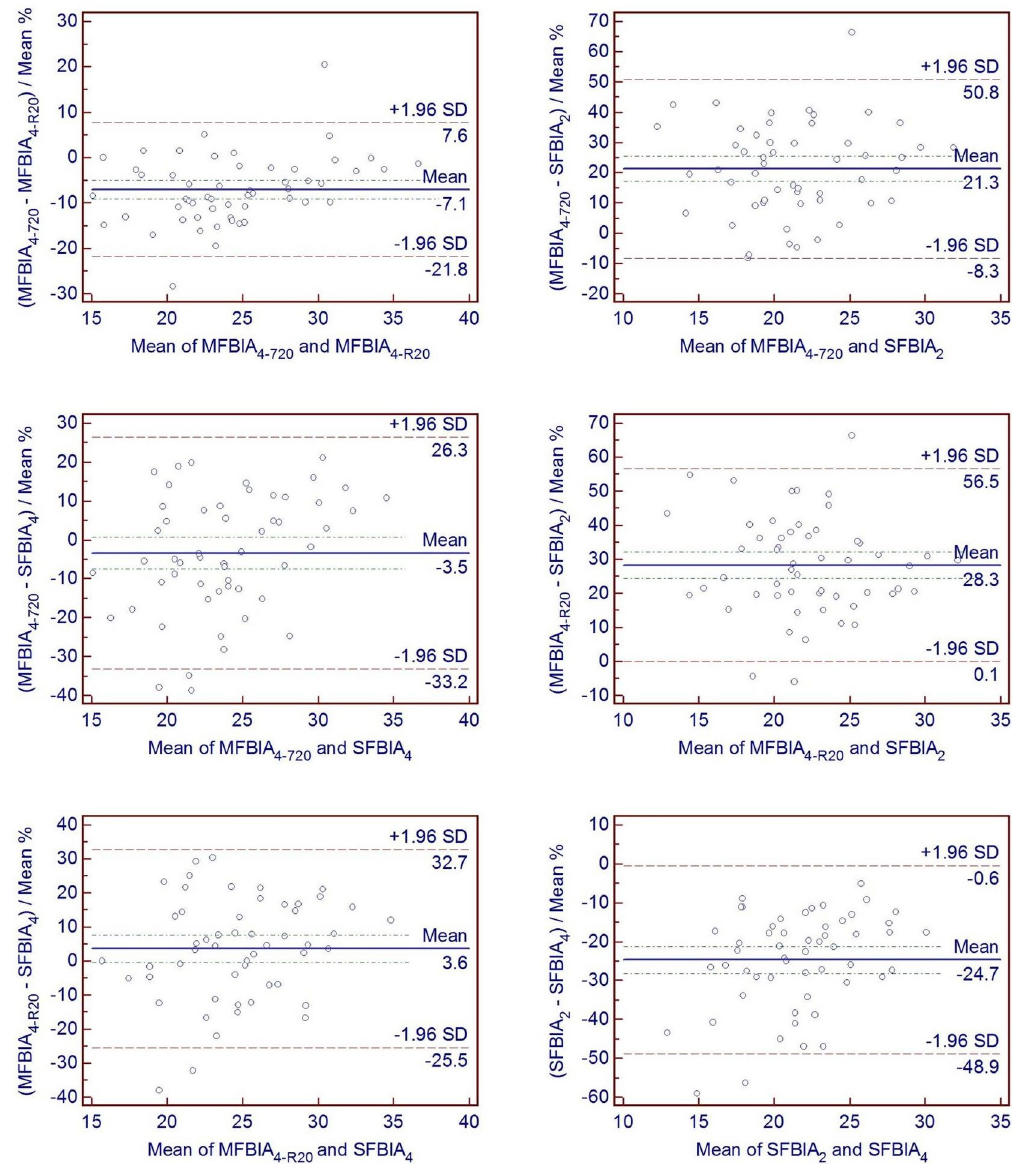
Bland-Altman plots with 95% limits of agreement and correlation analysis of the differ- ences between the body fat values measured by the used analyzers in percentage –